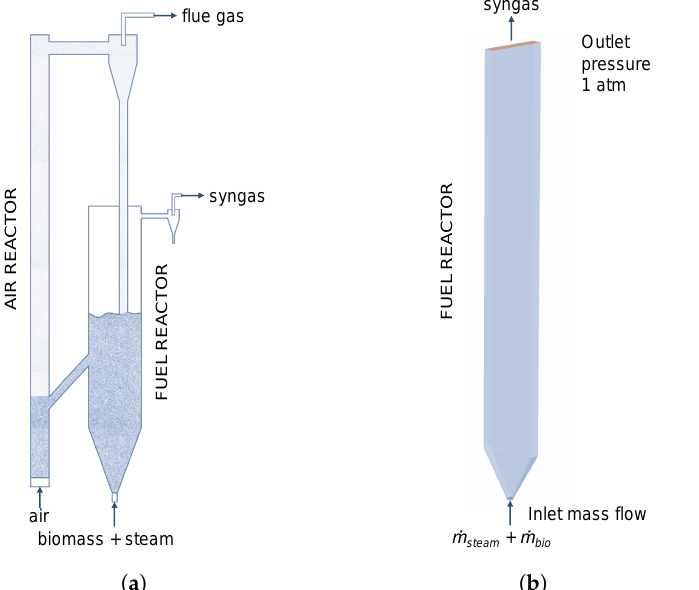
Figure 3. ( a ) Schematic representation of the experimental plant adopted from Song et al. [6]. ( b ) Sim- ulation geometry of the fuel